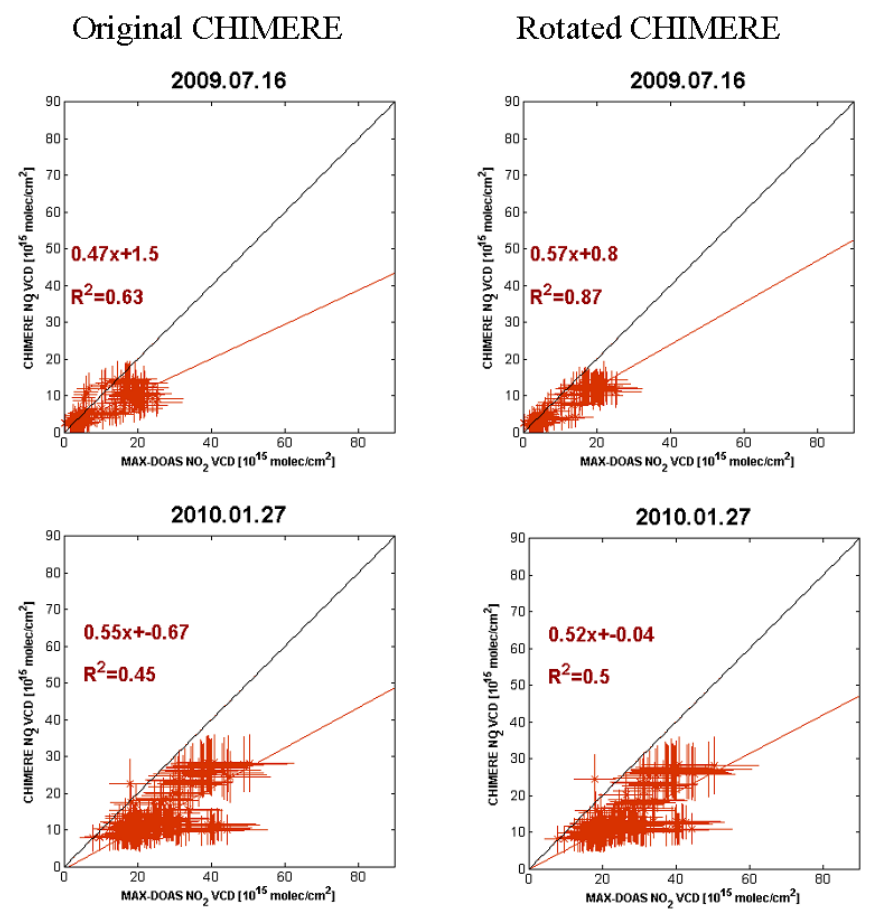
Figure 7. Correlation analyses of original (left) and rotated (right) CHIMERE data versus coincident car-MAX-DOAS observations for 2 selected days. On 16 July 2009 (top) the rotation substantially improves the correlation. On 27 January 2010, the rotation only leads to a slightly improved correlation.